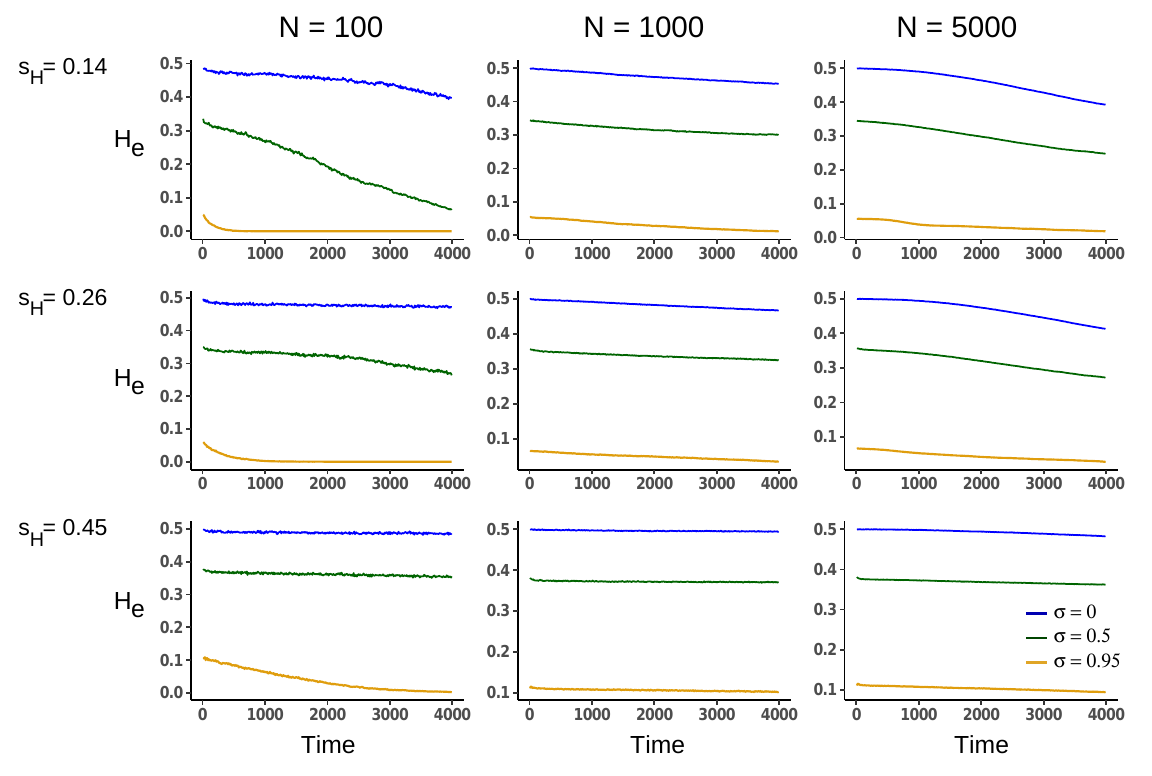
Figure S2 – Mean declines in heterozygosity H e with time for different population sizes, N , and selection coefficients against homozygous haplotypes, s H . Simulations reflect three selfing rates ( σ = 0, 0.5 and 0.95 ). Individual loci within the POD zone have a se- lection coefficient s = 0.01 , dominance h = 0.2 , and map length (or the recombination 5 rate)between loci in the POD zone is ℓ = 10 − . There are no background